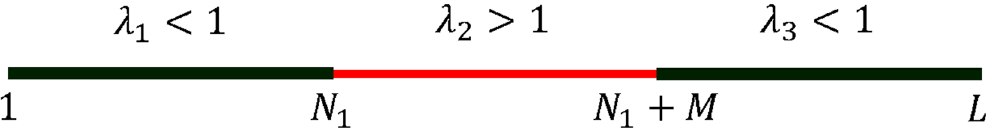
Figure 2. The nonuniform Ising-Kitaev chain split into two “topological” (dark green) and one “trivial” (red) regions. The first “topological” region is characterized by the parameter λ 1 < 1 and occupies the left part of the chain, ⩽ ⩽ n N 1 . The next M sites are occupied by the “trivial” phase with λ 2 > 1. The remaining portion of the 1 chain of the length = − − N L N M is occupied by the second “topological” region with λ 3 < 2 1